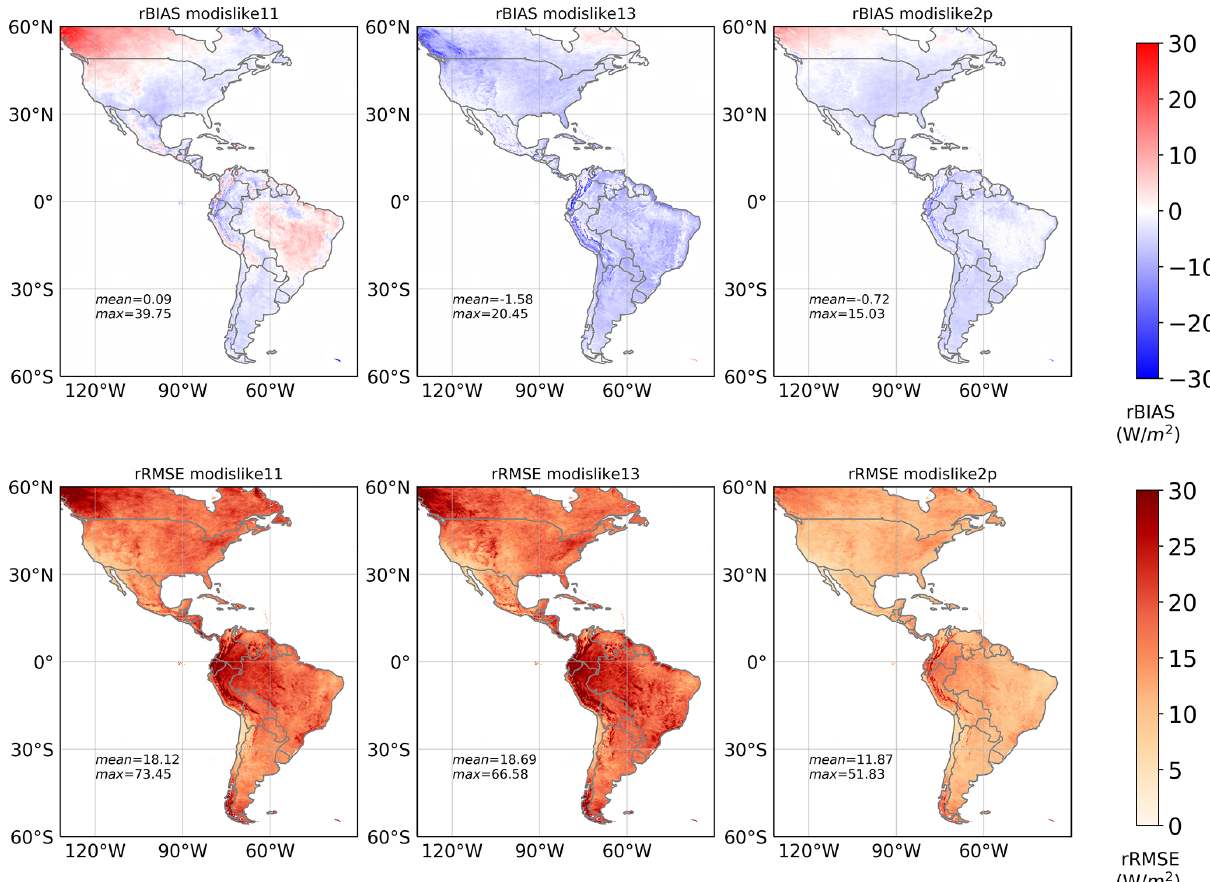
Figure 14. The temporal representation maps showing the rBias (relative bias) and the rRMSE (relative RMSE) of daily-averaged DSR between the GeoNEX product and the MODIS-interpolated data from visibility index at local times of 11:00 (modislike11), 13:00 (modis- like13), and both